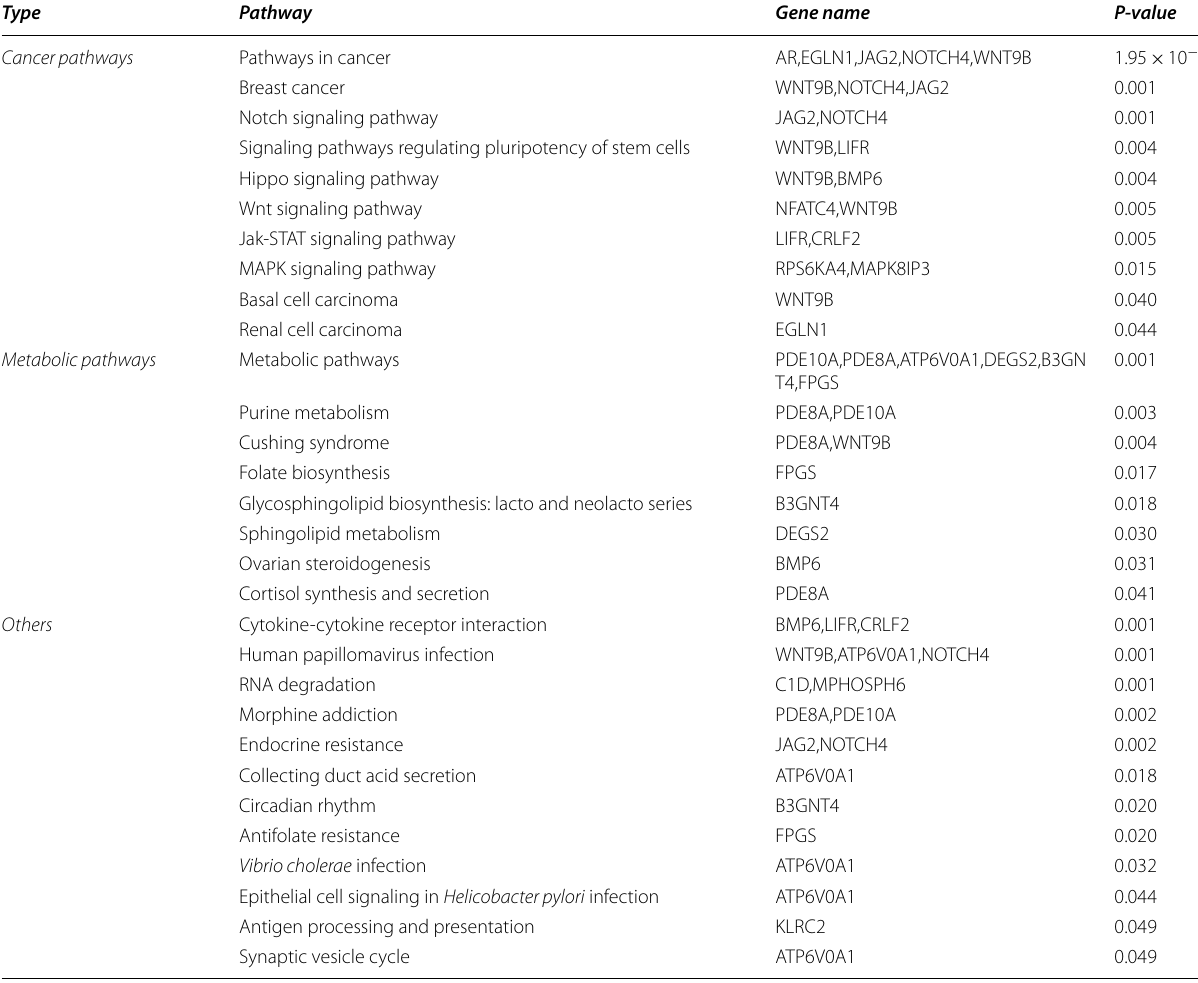
Table 2 Differential SNPs and major pathways between tumor tissues and normal tissues in our patient